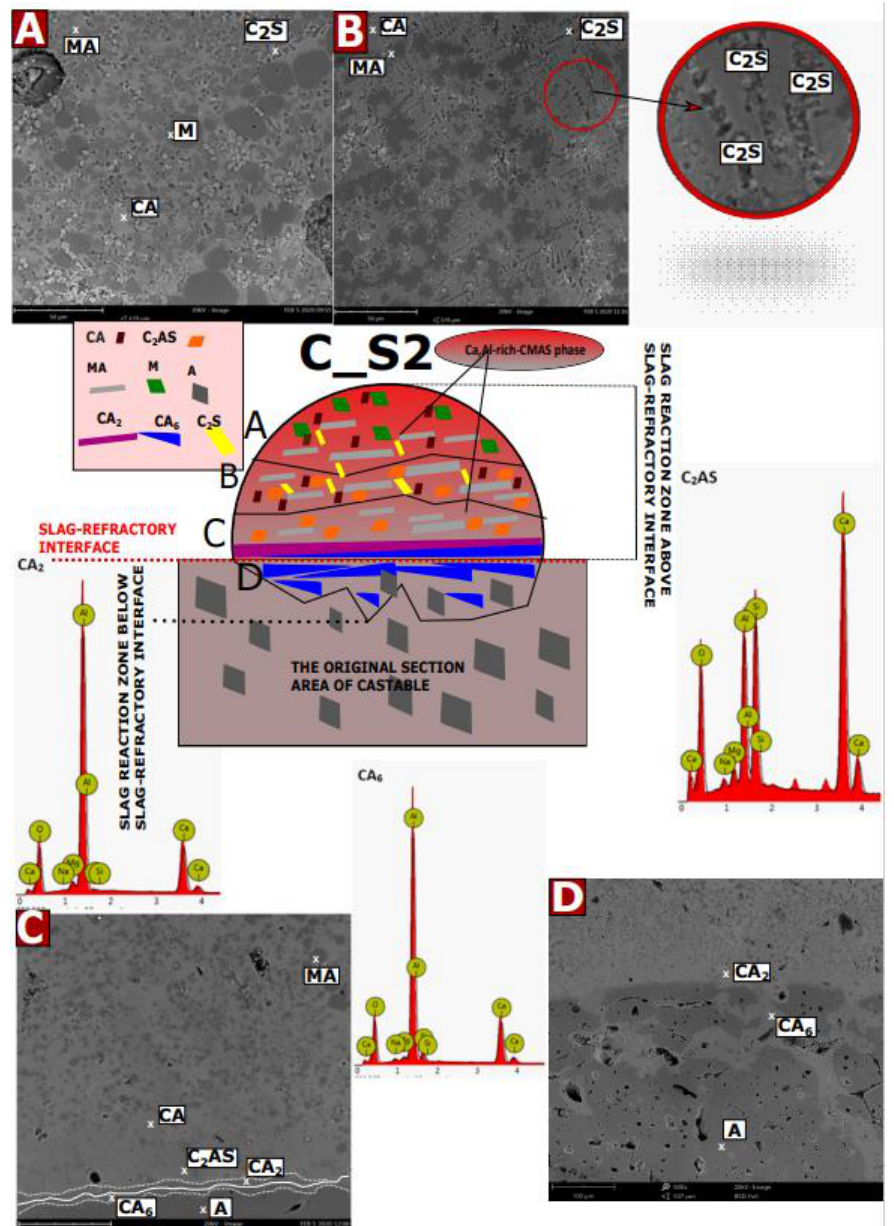
Figure A2. ( A – D ) In the center is a schematic diagram of the phases present in the castables-slag S2 sample after corrosion. In the corners, there are photos of SEM micro-areas, as well as selected EDS.